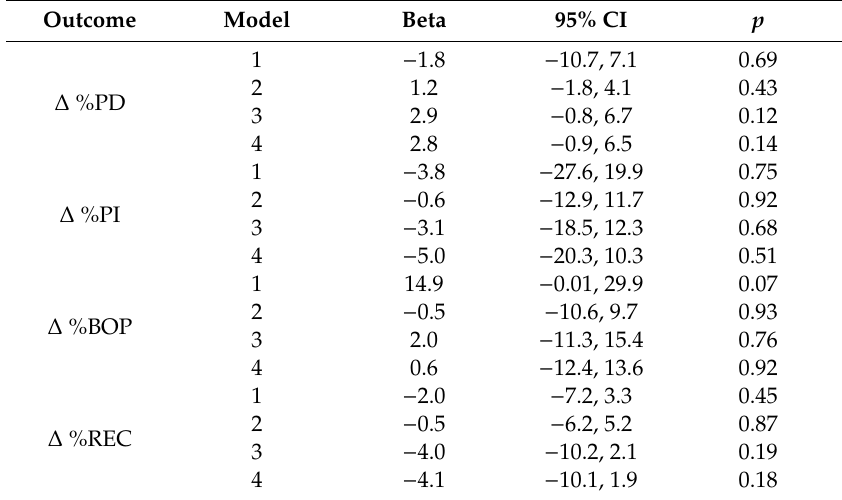
Table 3. Linear regression models of difference (T1 − T0), delta ( Δ ), for each periodontal variable. Outcome Model Beta 95% CI p 1 Δ %PD − 0.9,